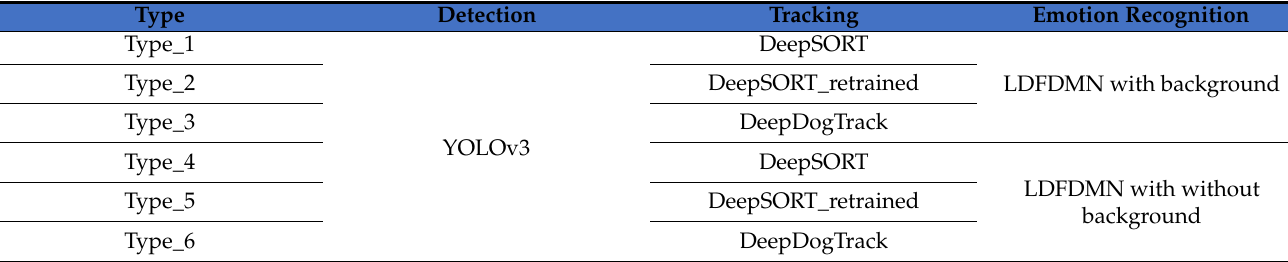
Table 2. Dog emotion recognition model types.